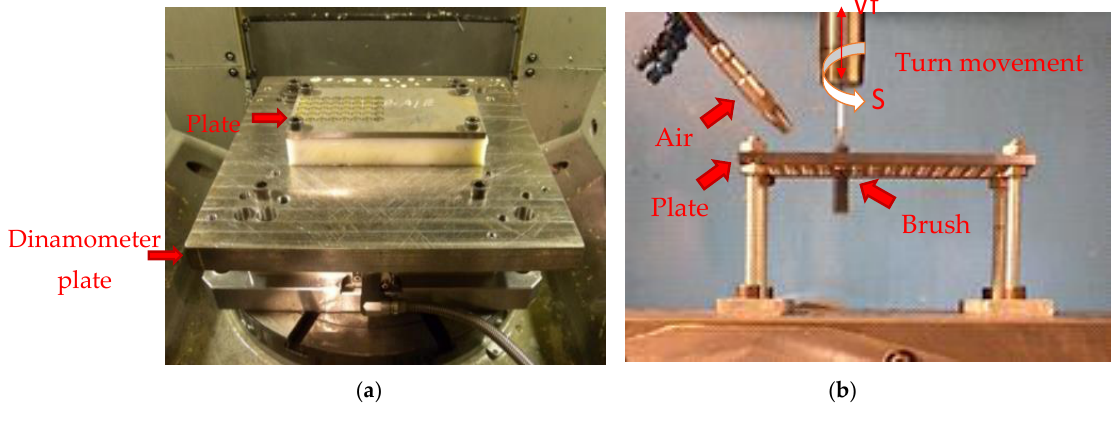
Figure 2. ( a ) Drilling set-up. ( b ) Brushing set-up.